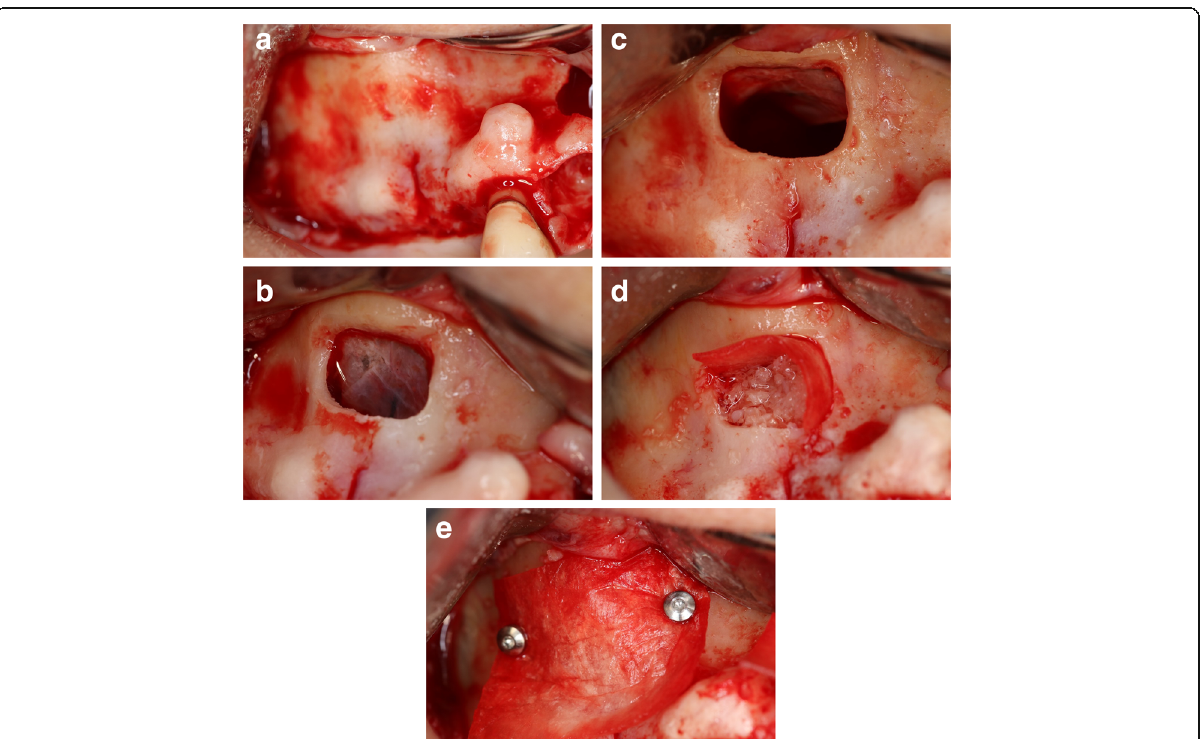
Fig. 2 a Full-thickness flap reflected to access the lateral sinus wall. b Lateral window created. c Schneiderian membrane completely elevated to medial expose the medial wall. d Test sinus filled with Osteocel Plus allograft material. e Collagen resorbable membrane covers the window and stabilized with 2 tacks one anteriorly and the other one